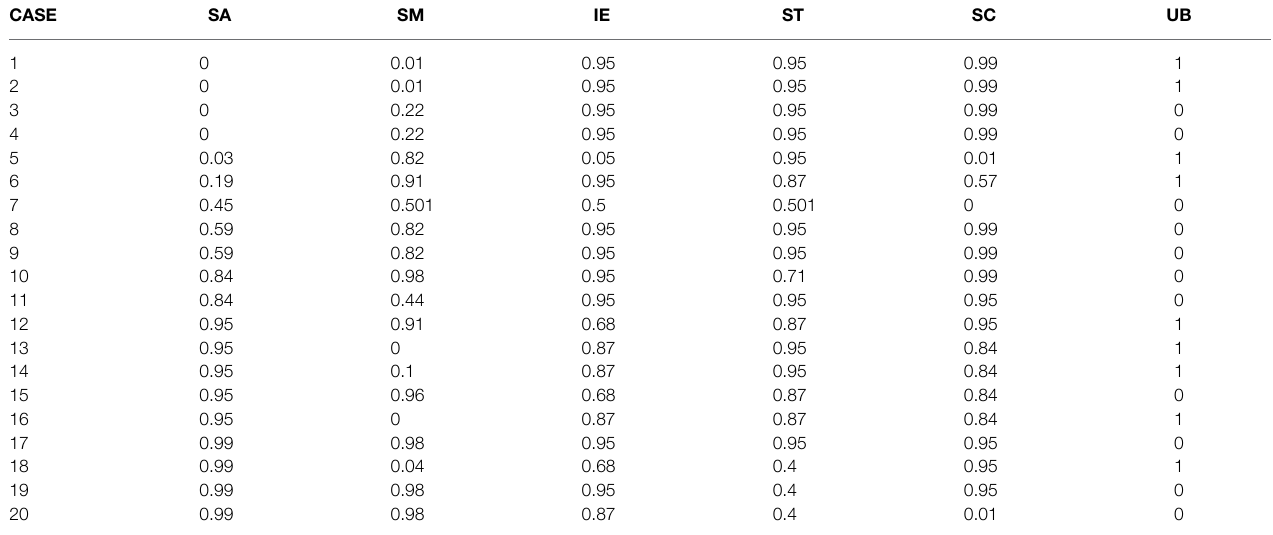
TABLE 7 | Variable calibration results